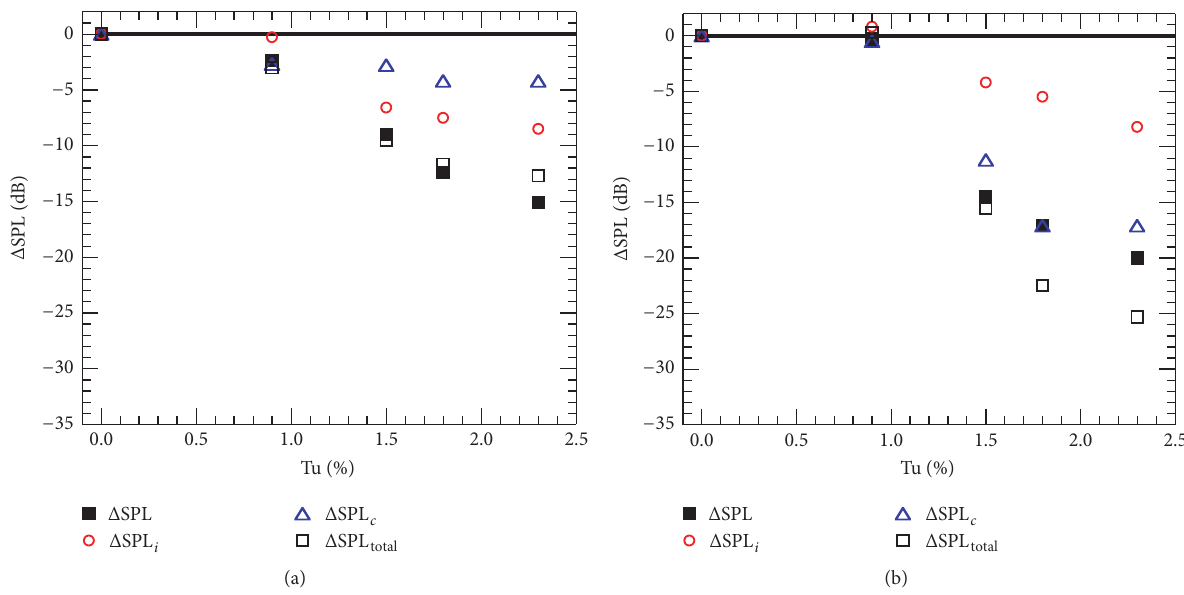
Figure 24: Effects of intensity and spanwise coherence of sound source on variation of cavity tone. (a) Cavity flow without acoustic resonance ( D / L = 0.5). (b) Cavity flow with acoustic resonance ( D / L =